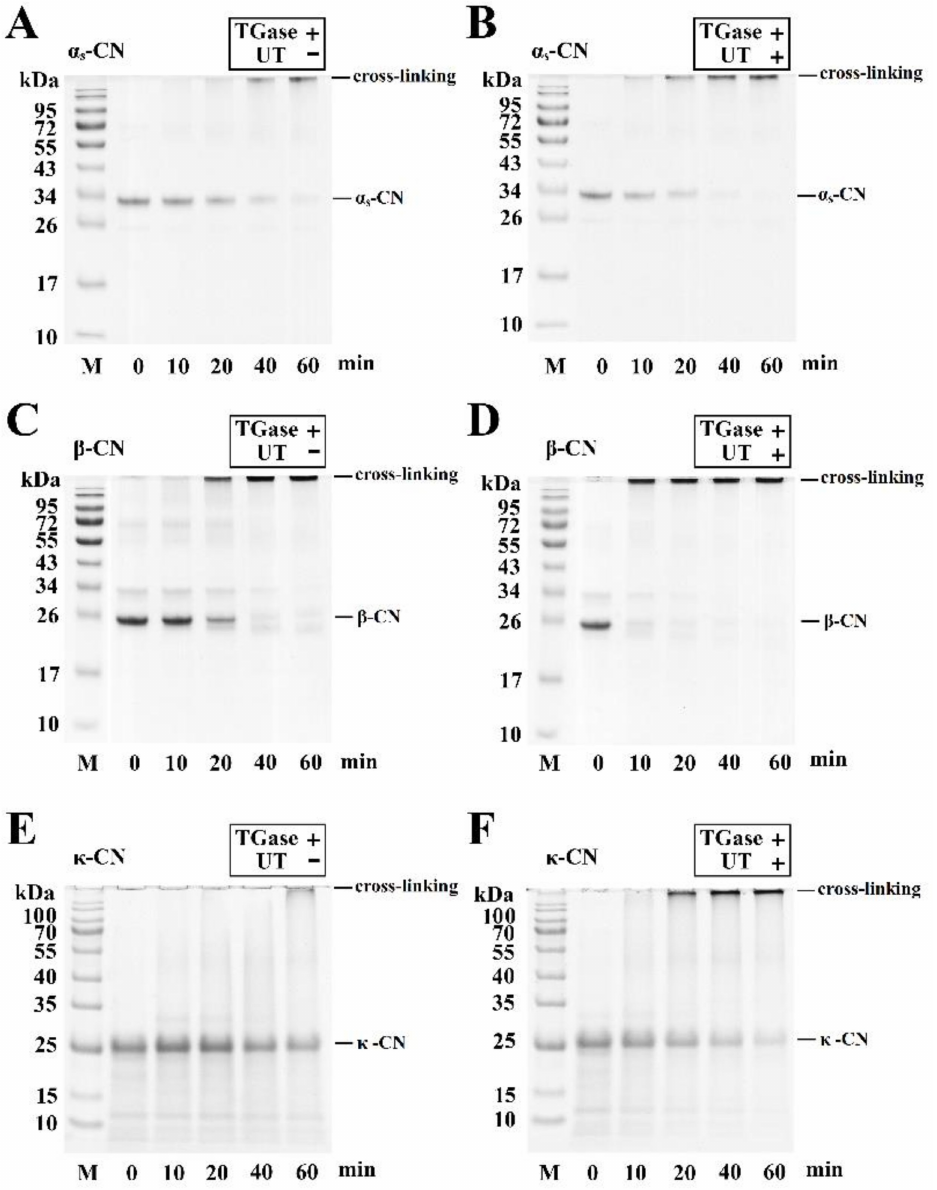
Figure 3. SDS-PAGE image showing individual α s -CN, β -CN and κ -CN treated with TGase (6.0 units/mL) and UT at 30 ◦ C for 0, 10, 20, 40 and 60 min. ( A ) α s -CN with TGase, ( B ) α s -CN with TGase and UT, ( C ) β -CN with TGase, ( D ) β -CN with TGase and UT, ( E ) κ -CN with TGase, and ( F ) κ -CN with TGase and UT. M = protein marker. The experiments on the sample were performed in